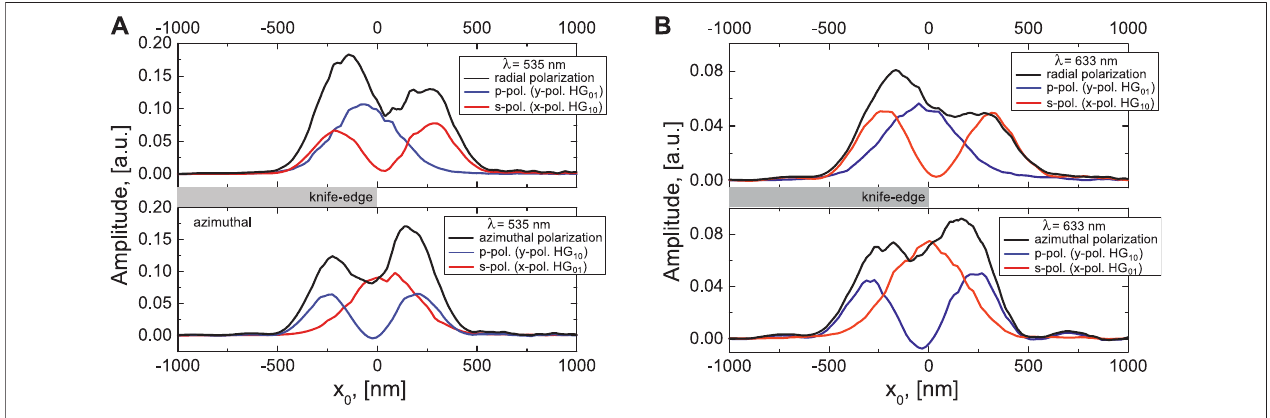
FIGURE 6 | Experimentally measured projections of radially and azimuthally polarized beams (black) and their linear s -, p - polarized constituents (red, blue) for (A) λ (cid:1) 535nm, (B) λ (cid:1) 633nm.Theaccuracyofdeterminingtheactualpositionoftheprojectionsrelativetotheknife-edgeislimitedbytheerrorinmeasuringthewidth d the knife-edge in an SEM.